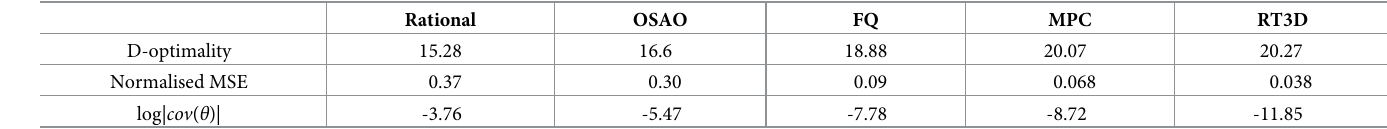
Table 4. Performance metrics for optimal experimental design on the chemostat growth model. The best performing R3TD agent is